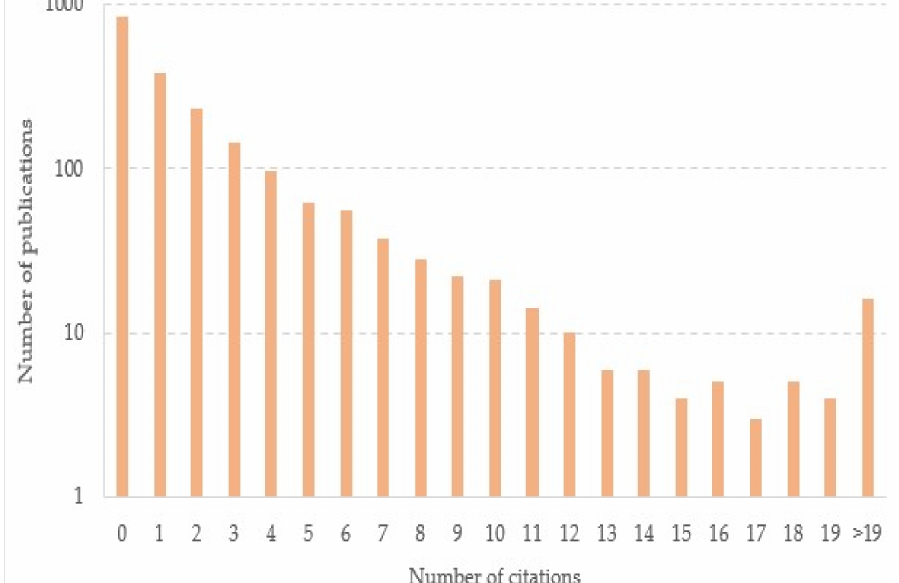
Figure 2. Logarithmic number of publications vs. number of